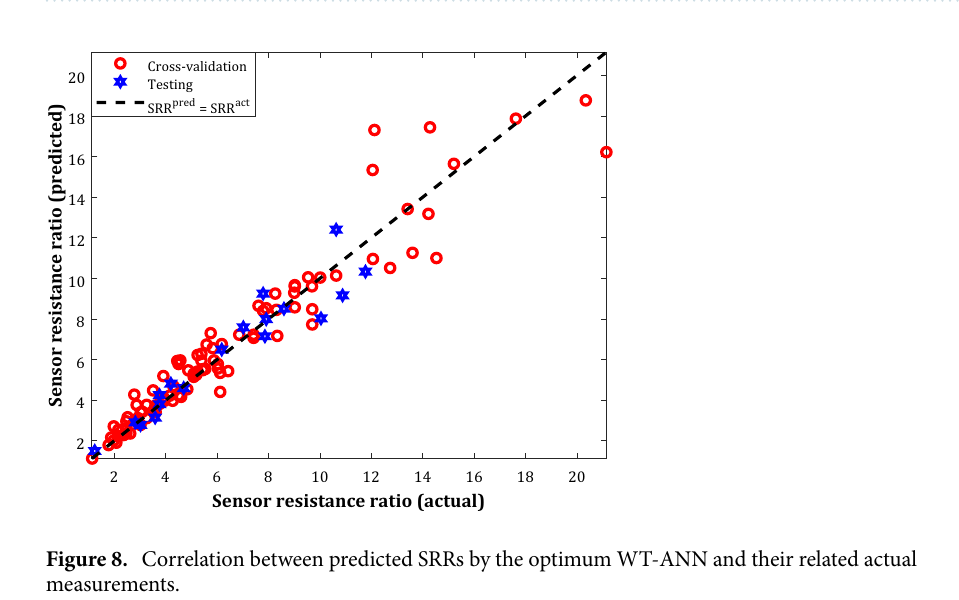
Figure 7. The histogram of the observed residual error by the optimum WT-ANN in the cross-validation and testing stages.